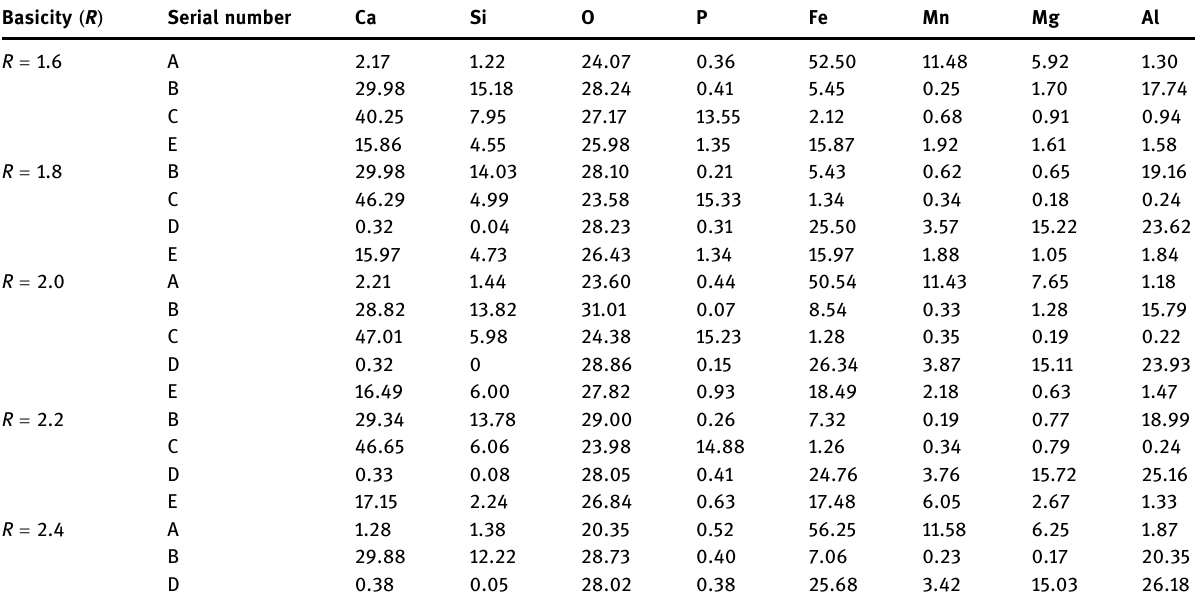
Table 7: Element content in each phase of mixed slag with di ff erent basicity wt% Basicity ( R )